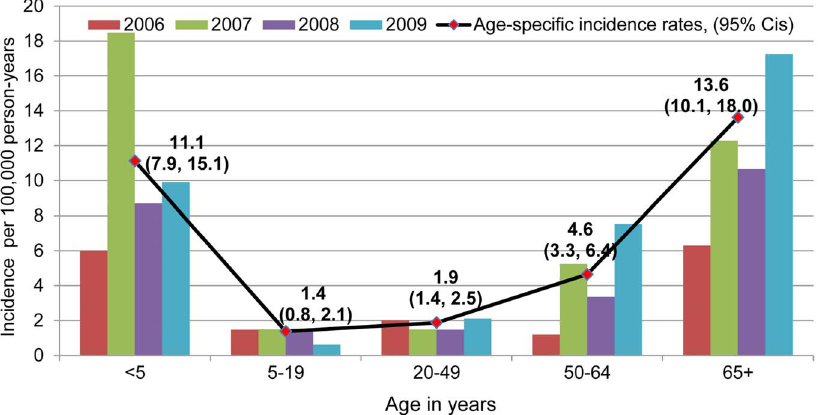
Figure 1. Hospitalized pneumococcal bacteremia incidence rates by year and age in rural Thailand, May 2005 to March 2010. Overall incidence 3.5 per 100,000 person-years, 95% CI (3.1, 4.1).